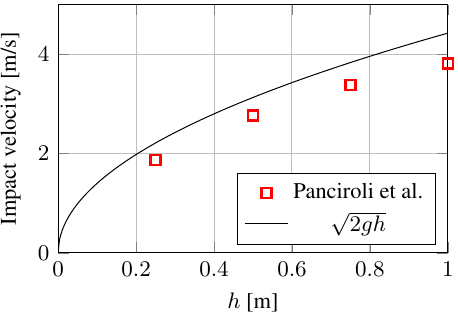
Figure 4. Impact velocity of the specimen as a function of the drop height. Experimental data retrieved from Reference